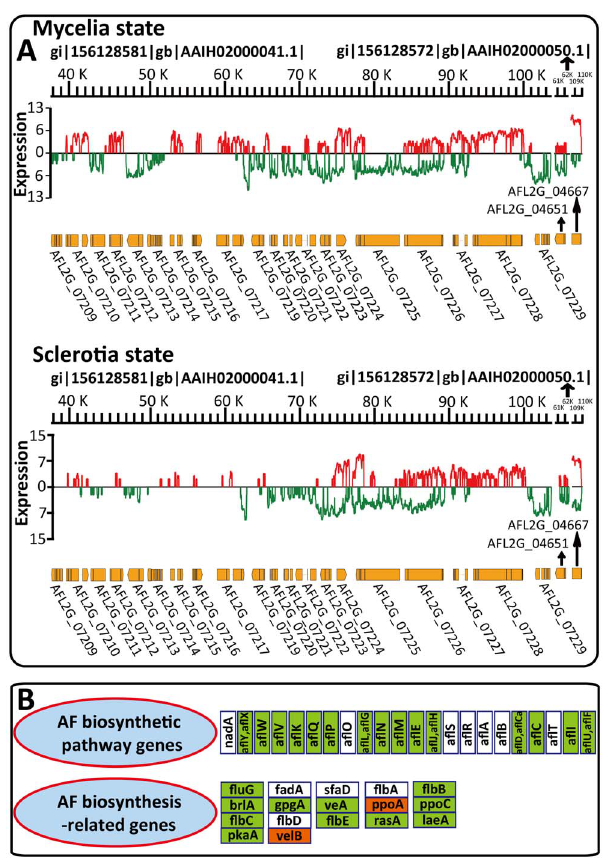
Figure 7. Differential transcription of A. flavus aflatoxin biosynthetic pathway. (A) The expression status of AF biosynthesis in the mycelia and sclerotia states. (B) The regulation model of AF biosynthesis-related genes in the mycelia and sclerotia states. The orthologs of the AF biosynthetic pathway genes are in the same order as in (A). Boxes, DEGs ( p , 0.001 and change . 2-fold) between mycelia and sclerotia states, denoted by the names of their homologs in A. nidulans . Red and green boxes, up-regulated and down-regulated genes in the sclerotia state, respectively. White boxes, genes with no significant change between the mycelia and sclerotia